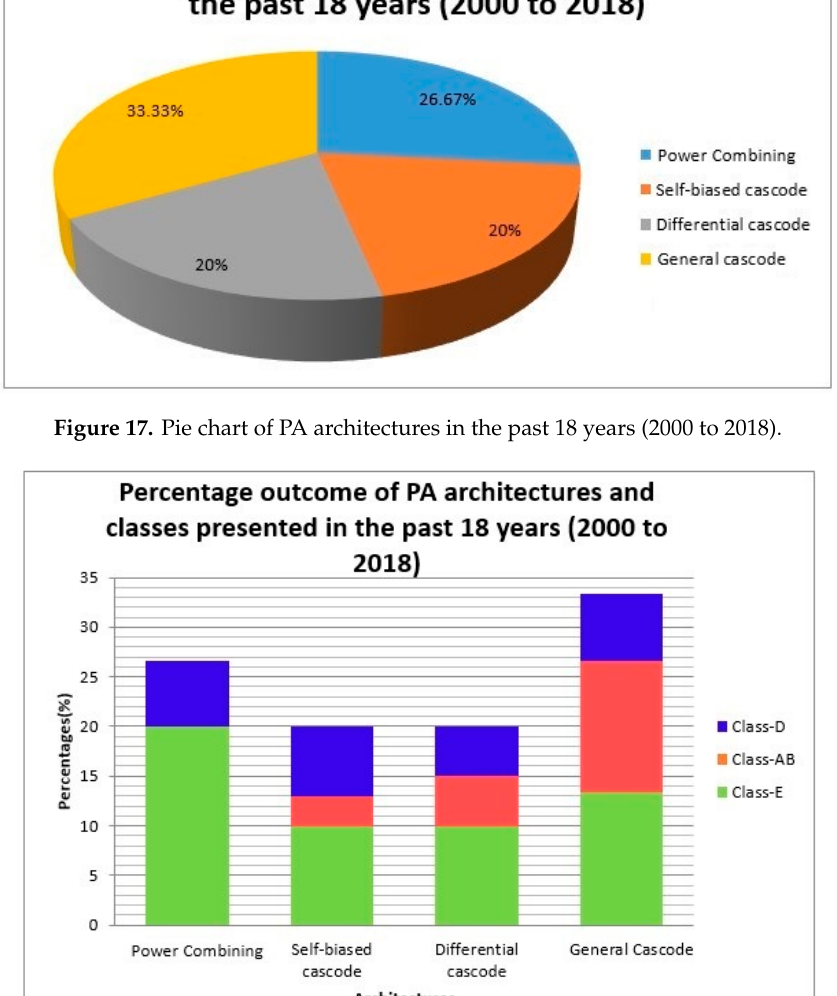
Table 1. Performance analysis between different PA design techniques.